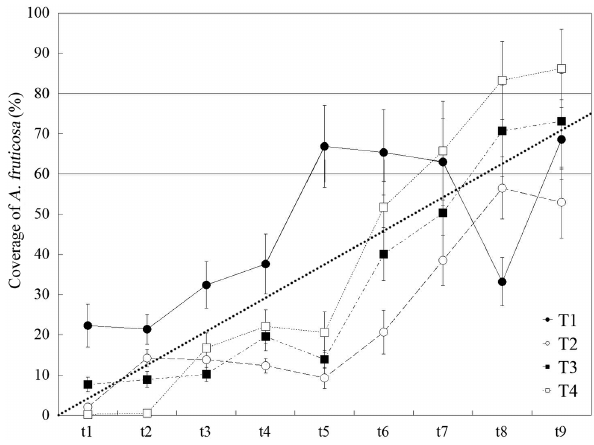
Figure 4. Coverage of A. fruticosa sowed with different herbaceous seeds. Note: each spot with an error bar is the mean value of cov- erage of A. fruticosa during the experimental period. The dotted line indicates a predicted coverage of A. fruticosa under different seeding densities based on the assumption that the coverage is pro- portional to the amount of seeds